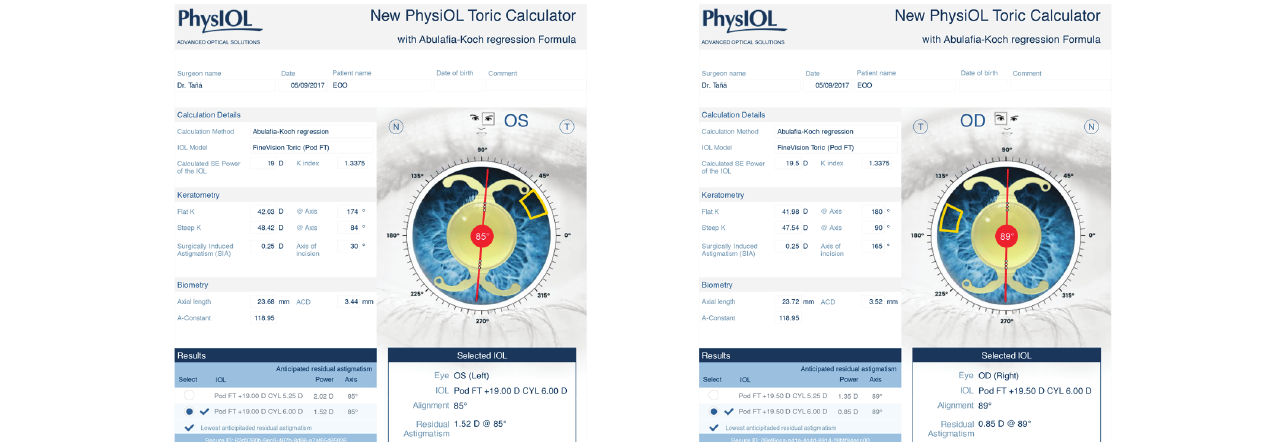
Figure 4. Proposed intraocular lens according to the PhysIOL toric online calculator.